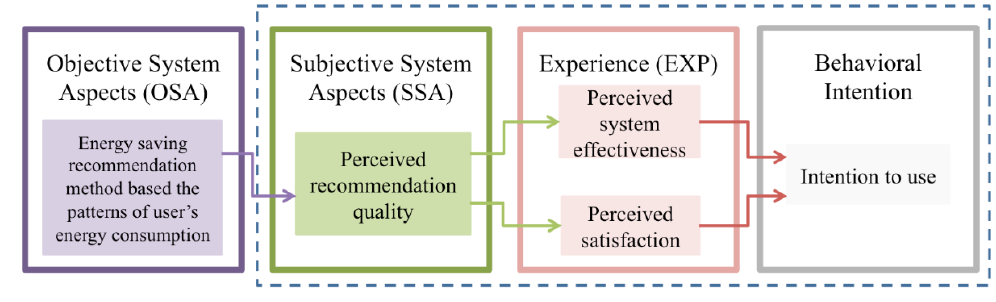
Figure 8. User-centered theoretical model.